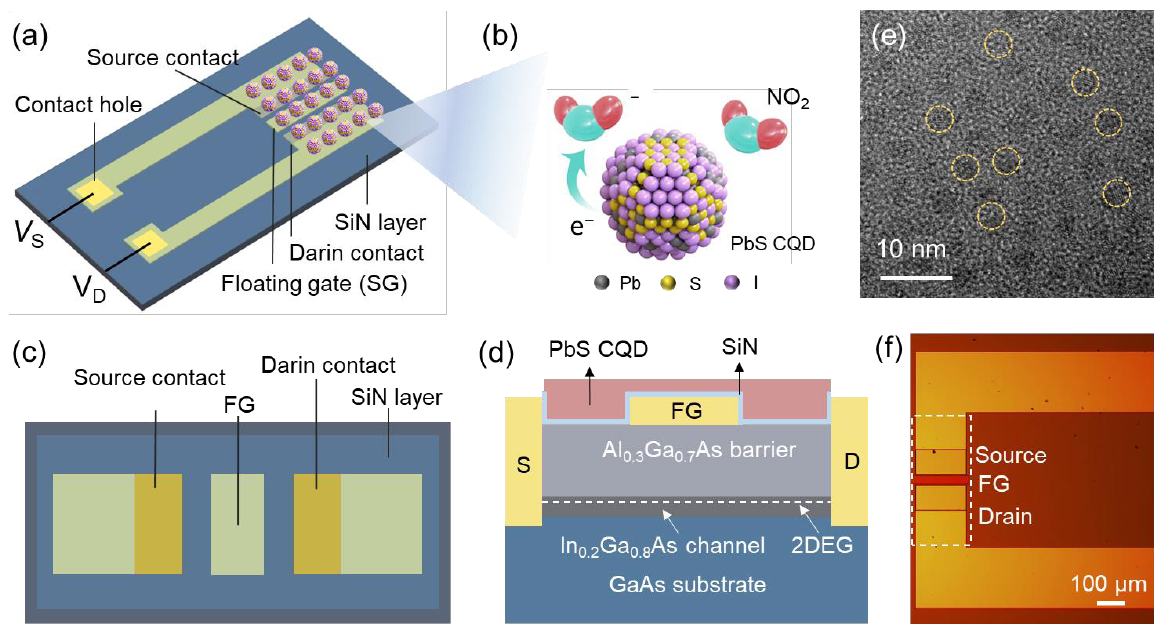
Figure 1. Illustration of the proposed quantum dot gate-sensitive HEMT gas sensor. ( a ) Three-dimensional diagram of the gas sensor showing the AlGaAs/InGaAs/GaAs epitaxial layer, the source and drain electrodes, the floating gate, the SiN passivation layer, and the PbS quantum dot film; ( b ) Schematic of the sensing mechanism of PbS quantum dots to NO 2 gas; ( c ) Schematic top view of the sensor chip; ( d ) Schematic cross-section of the sensor chip; ( e ) HRTEM image of PbS CQDs, the CQDs were circled by the yellow dotted line; ( f ) Optical microscope image of the sensor chip.